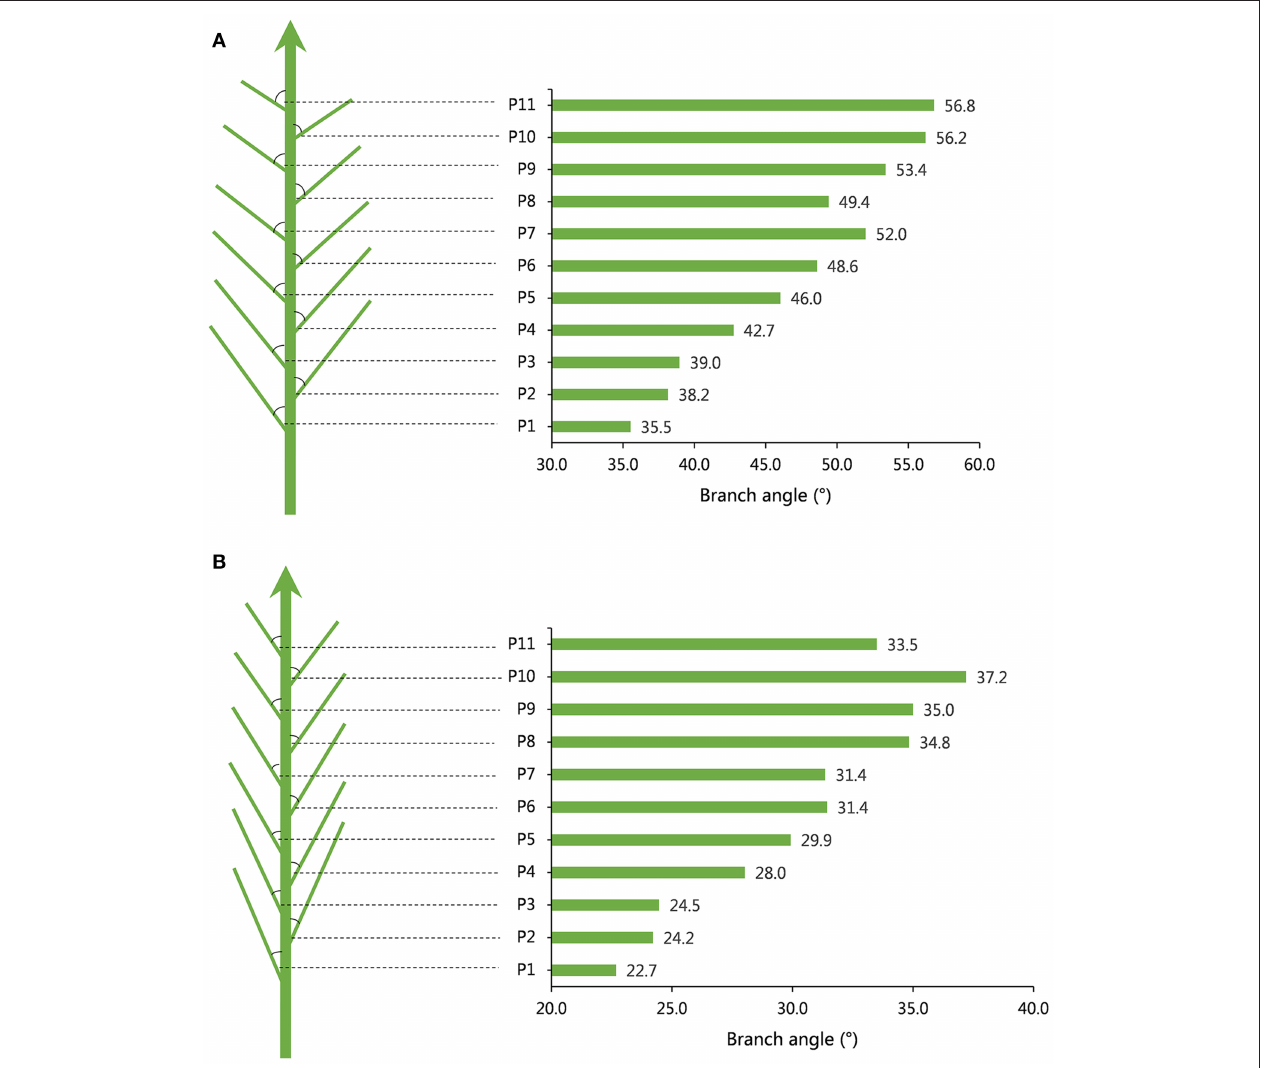
FIGURE 1 | Models of branch angle for loose and compact plant architecture in rapeseed. (A) A model for branch angle of loose plant architecture in accession 1218 with a large branch angle and the angle tendency of different branch positions. (B) A model for branch angle of compact plant architecture in accession 3304 with a small branch angle and the angle tendency of different branch